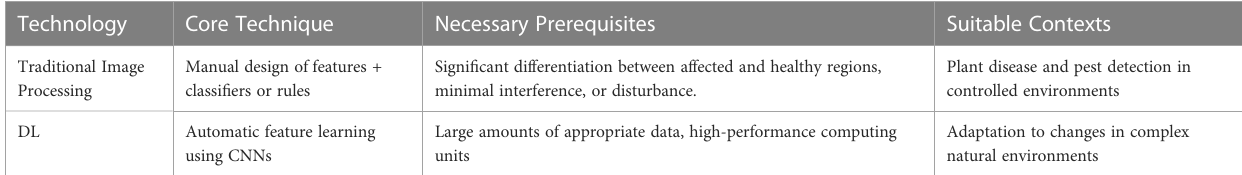
TABLE 1 Comparison of different technologies for image